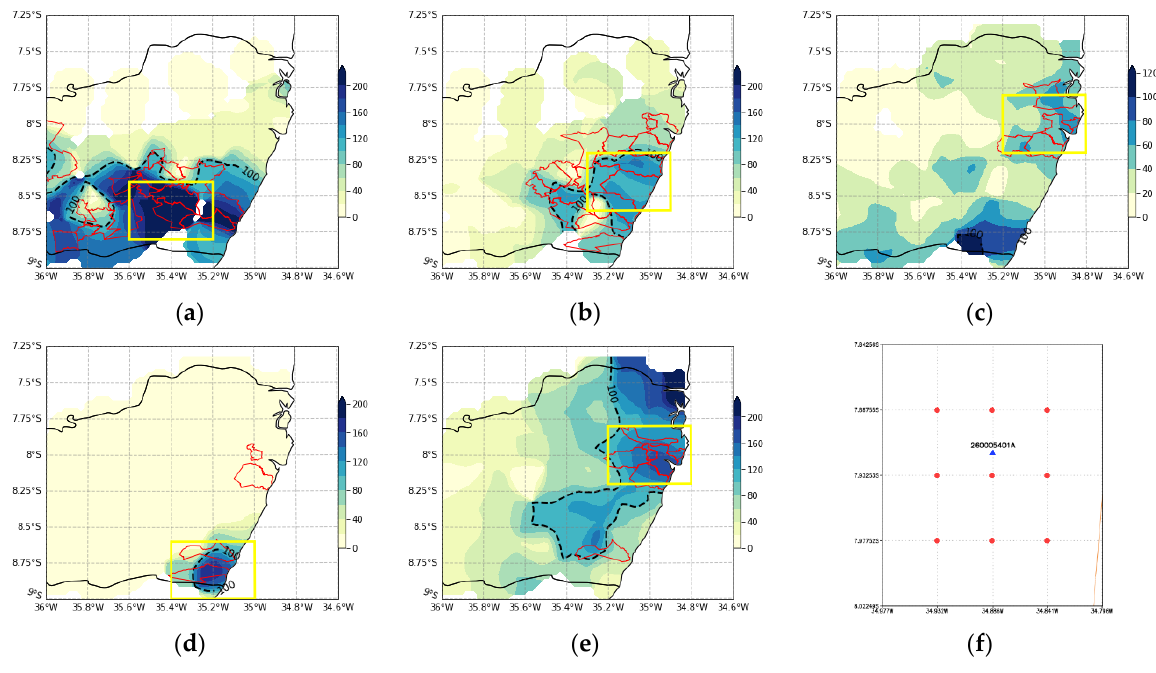
Figure 2. The blue shading ( a – e ) is the 24-h precipitation accumulation (mm/24 h) recorded by the rain gauges and interpolated using the Cressman technique with a 15 km radius. ( a ) Precipitation ranges from 20170527 12UTC to 20170528 12UTC, ( b ) from 20170720 00UTC to 20170721 00UTC, ( c ) from 20180422 00UTC to 20180423 00UTC, ( d ) from 20190528 12UTC to 20190529 12UTC, and ( e ) from 20190613 00UTC to 20190614 00UTC. The dotted line in black marks the 100 mm/24 h isohyet, the red areas are the municipalities affected by natural disasters, and the yellow boxes are the intersection regions between the heaviest rainfall and the municipalities affected by natural disasters and where the diagnostic analyses were performed. ( f ) Schematic sketch with the position of a rain gauge (blue triangle) and the nine grid points used to calculate the average rainfall (red points).